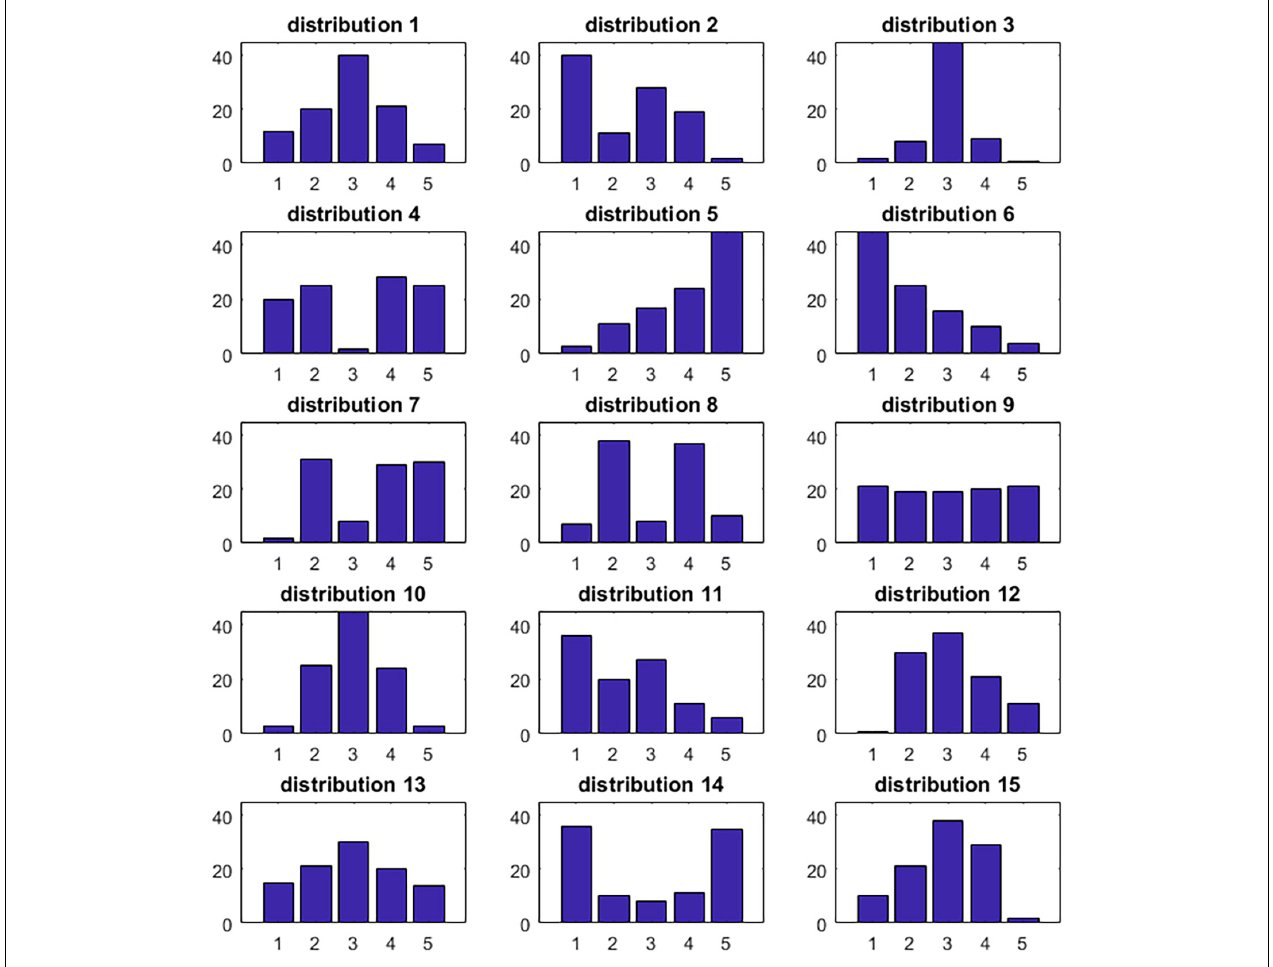
FIGURE 1 | Distributions that were judged by 60 experts on the extent to which they represented a polarized